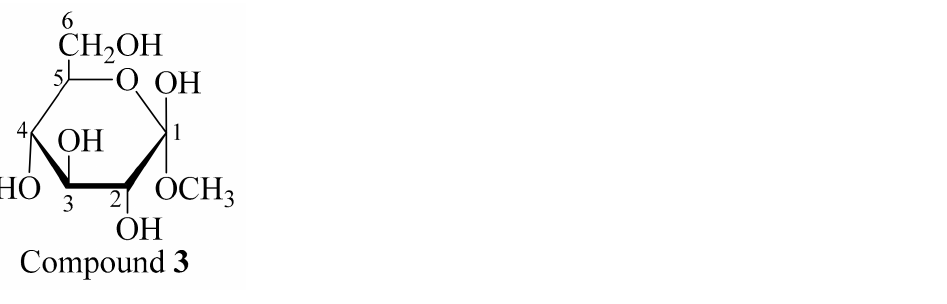
Figure 3. Chemical structure of compound 3 , methyl- α - D